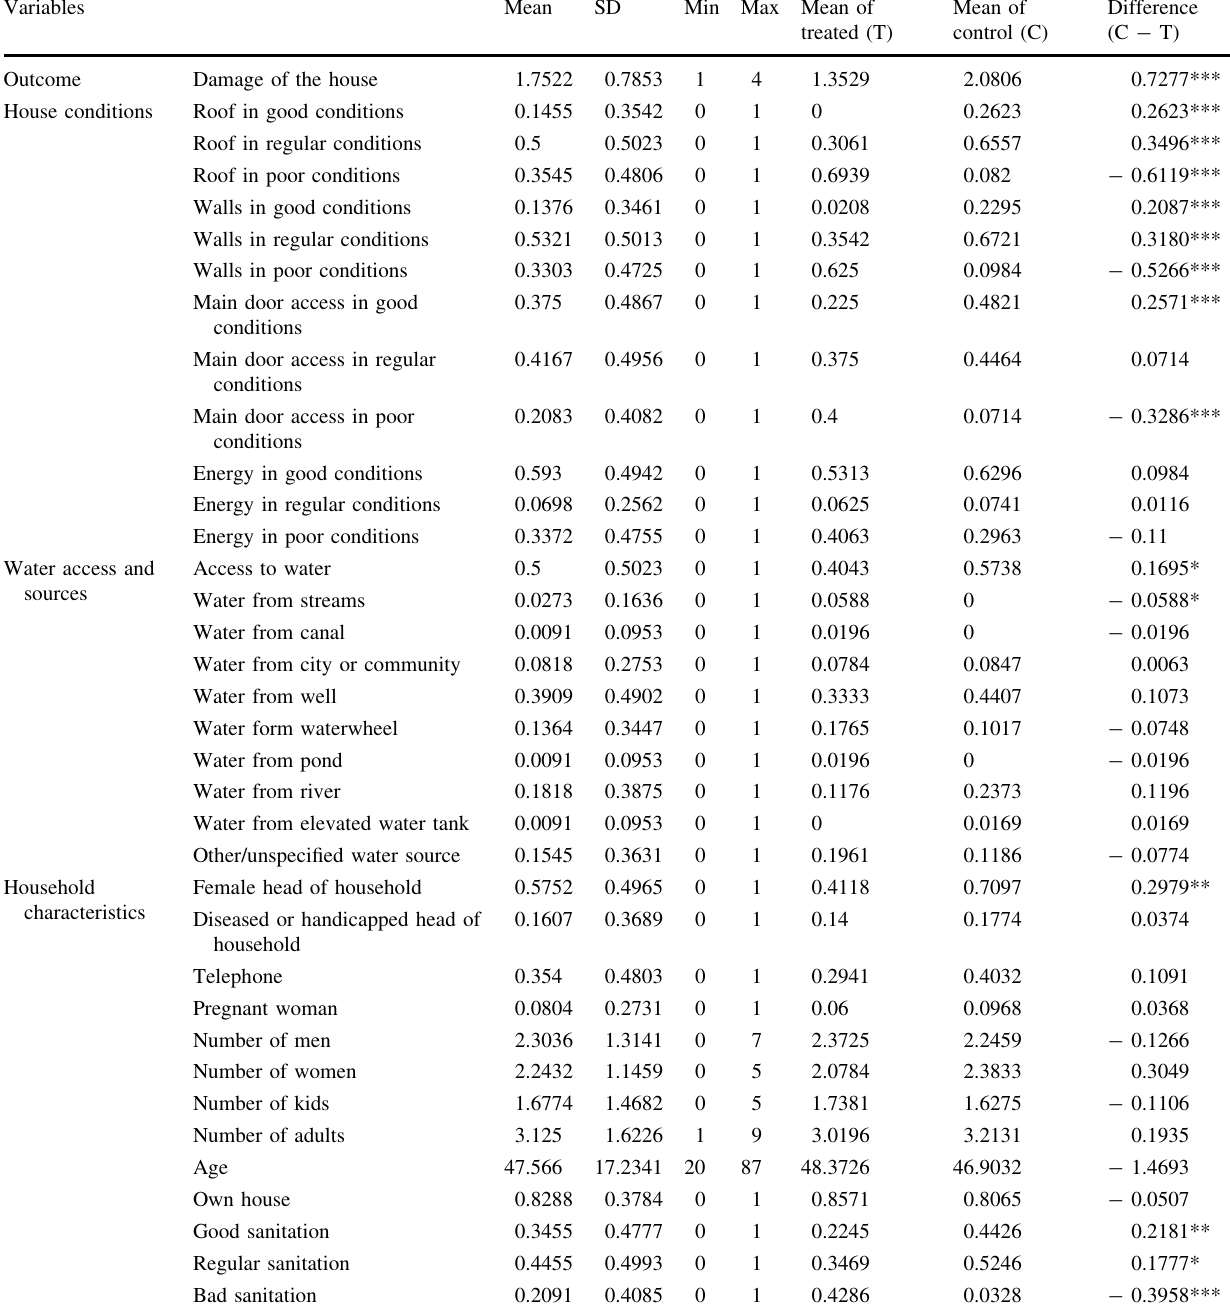
Table 2 Characteristics of treatment and control groups of houses studied in Picsi, Chiclayo Province, Peru´